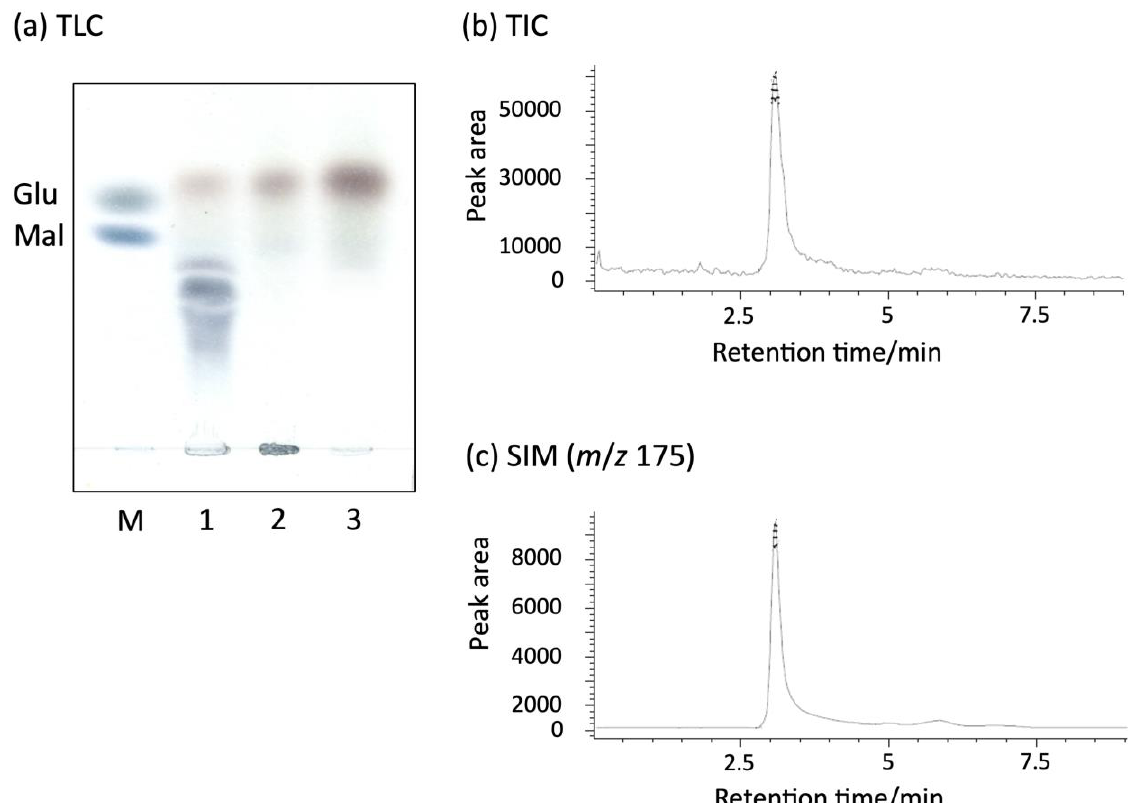
Figure 2. Degradation of sodium alginate by rAlyFRA or rAlyFRB. Sodium alginate reacted with rAlyFRA or rAlyFRB in 20 mM Tris-HCl buffer pH 7.5 at 25 °C for 3 d, and the products were analyzed using thin-layer chromatography (TLC) ( a ). M, Glucose and Maltose; 1, sodium alginate + AlyFRA; A2, sodium alginate + AlyFRB; and A3, sodium alginate + AlyFRA + AlyFRB. Identification of degraded products by AlyFRA + AlyFRB using total ion current (TIC) ( b ) and selected ion monitoring (SIM) ( c ) for identifying the degraded products of rAlyFRA and rAlyFRB. Peaks from both TIC and SIM at the retention time of 3 min indicate DEH.